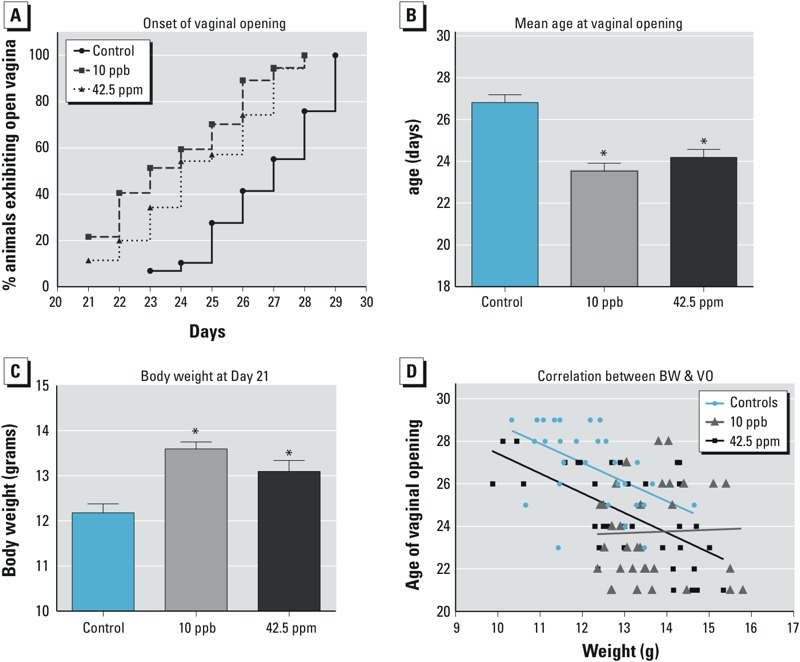
Effects of in utero arsenic exposure on onset of vaginal opening and body weight. (A) The x-axis represents the day of vaginal opening. The y-axis represents the percentage of animals with open vaginas. (B) The y-axis represents the average age ± SE when vaginal opening was observed. (C) Average body weight at 21 days of age (average age ± SE); (D) lines represent correlations between body weight (BW) and onset of vaginal opening (VO).
*p < 0.05.